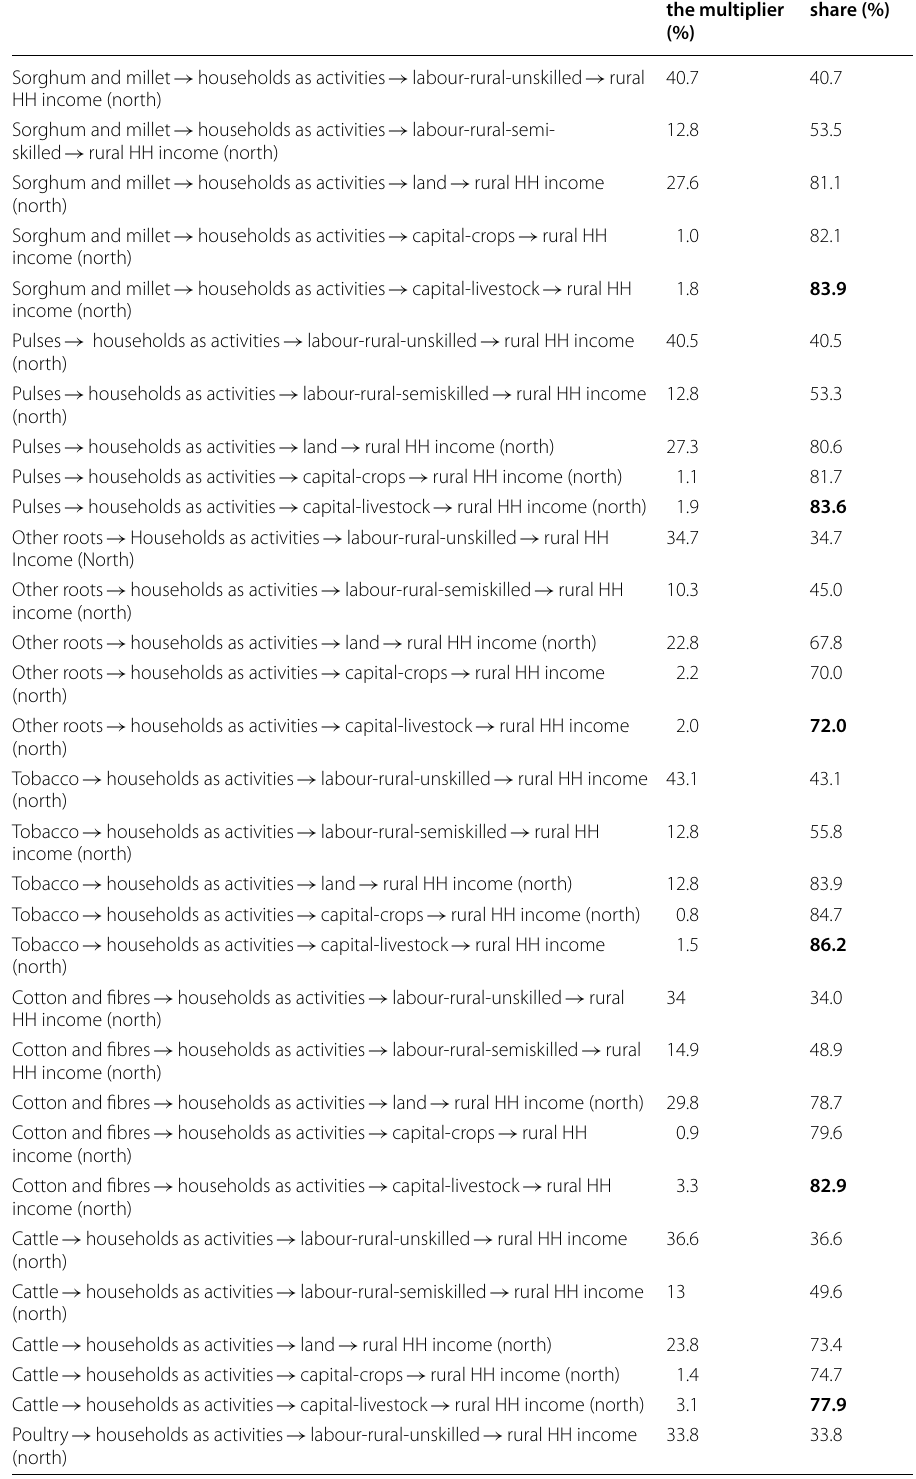
Table 6 Structural path analysis from agricultural commodities to north rural households income. Source: own